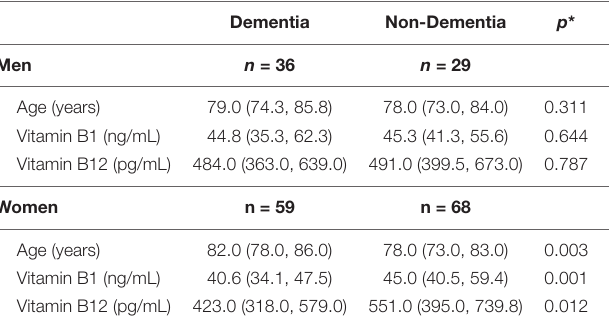
TABLE 3 | Comparisons of characteristics between the dementia group (MMSE ≤ 23) and the non-dementia group (MMSE > 23) according to sex. Dementia